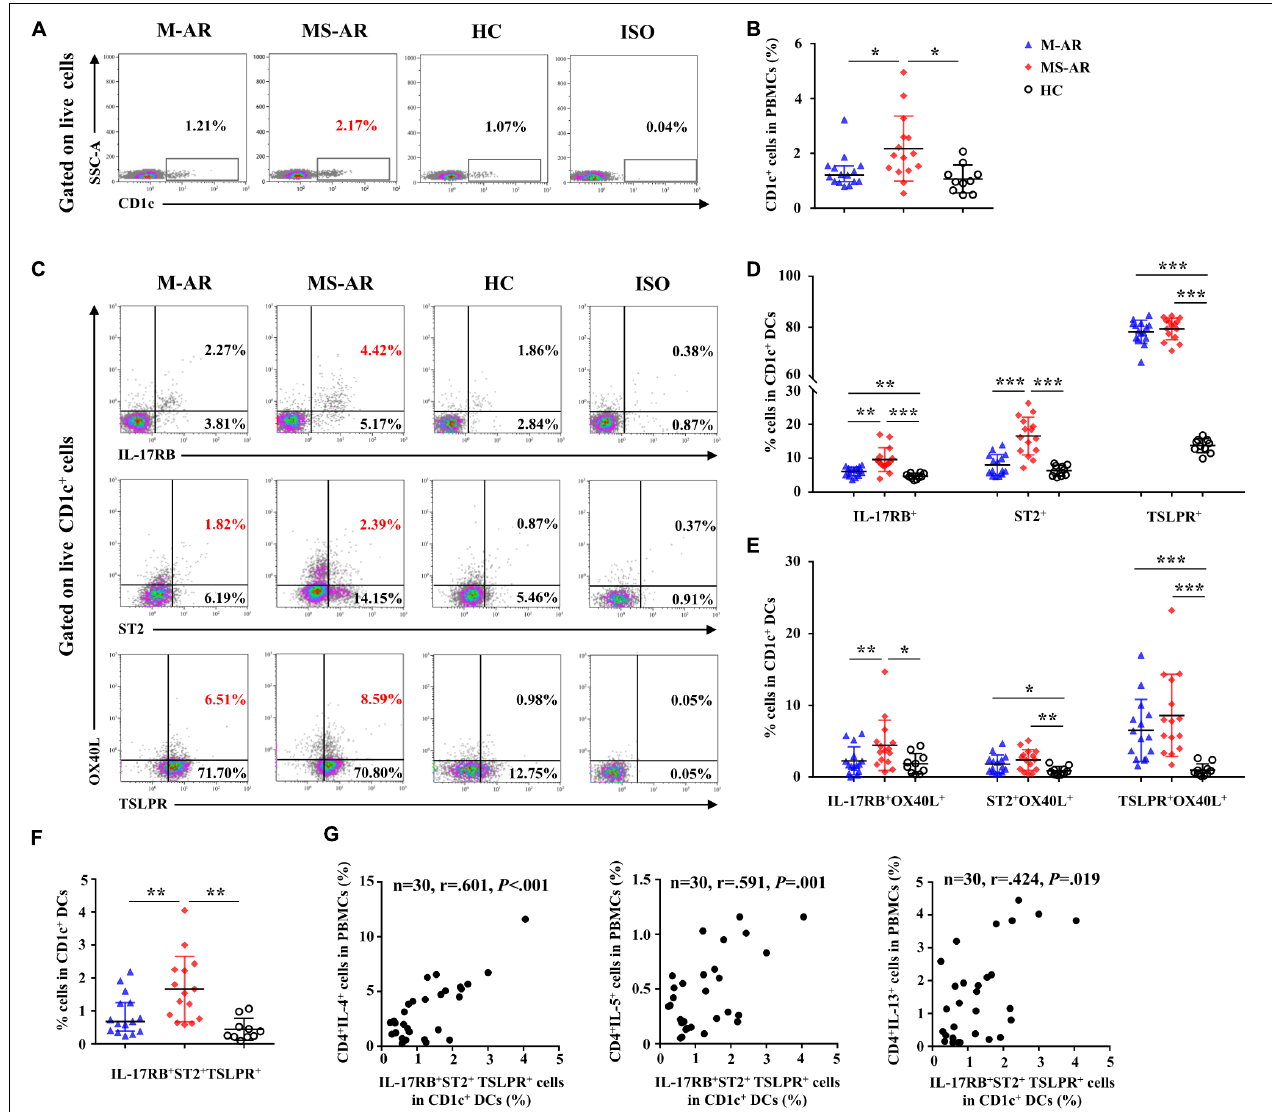
FIGURE 9 | Upregulation of IL-17RB, ST2, and TSLPR on myeloid DCs (mDCs) was associated with AR disease severity. (A) Representative flow plots of the percentage of CD1c + cells in PBMCs from M-AR ( n = 15), MS-AR ( n = 15), and HC ( n = 10) subjects. (B) Quantification of the percentage of CD1c + cells in PBMCs. (C) Representative flow plots of the percentage of IL-17RB + , ST2 + , TSLPR + , and OX40L + cells in CD1c + mDCs of PBMCs from M-AR ( n = 15), MS-AR ( n = 15), and HC ( n = 10) subjects. (D) Quantification of percentages of IL-17RB + , ST2 + , and TSLPR + cells in CD1c + mDCs of PBMCs. (E) Quantification of OX40L expression in IL-17RB + , ST2 + , and TSLPR + mDCs in PBMCs. (F) Quantification of the percentage of IL-17RB + ST2 + TSLPR + cells in CD1c + mDCs of PBMCs. Data were tested for normality using the Shapiro–Wilk test, and expressed as means ± SD or medians with IQR, according to normality test results. Significant differences were tested using Student’s t -test or the Mann–Whitney U- test between HC and AR groups, and using the paired t -test or Wilcoxon matched pairs signed rank test between M-AR and MS-AR groups. (G) Correlation of the percentage of IL-17RB + ST2 + TSLPR + mDCs with that of IL-4 + , IL-5 + , and IL-13 + T cells in PBMCs of M-AR and MS-AR patients ( n = 30) were analyzed using Spearman’s rank correlation coefficient ( r = 0.601, P < 0.001, 1– β = 0.956; r = 0.591, P = 0.001, 1– β = 0.948; and r = 0.424, P = 0.019, 1– β = 0.667, respectively). * P < 0.05, ** P < 0.01, *** P <